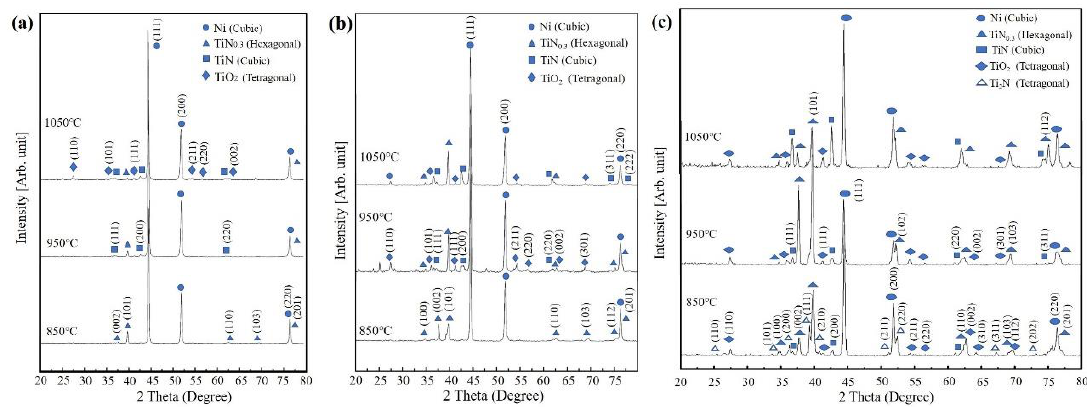
Figure 4. XRD spectra of the ( a ) T2N8, ( b ) T5N5, and ( c ) T8N2 compact sintered at various temperatures.